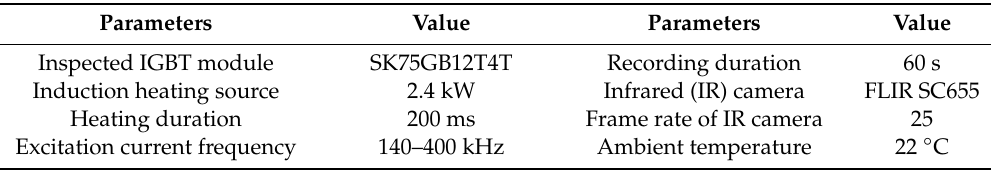
Table 2. ECPT system specifications.